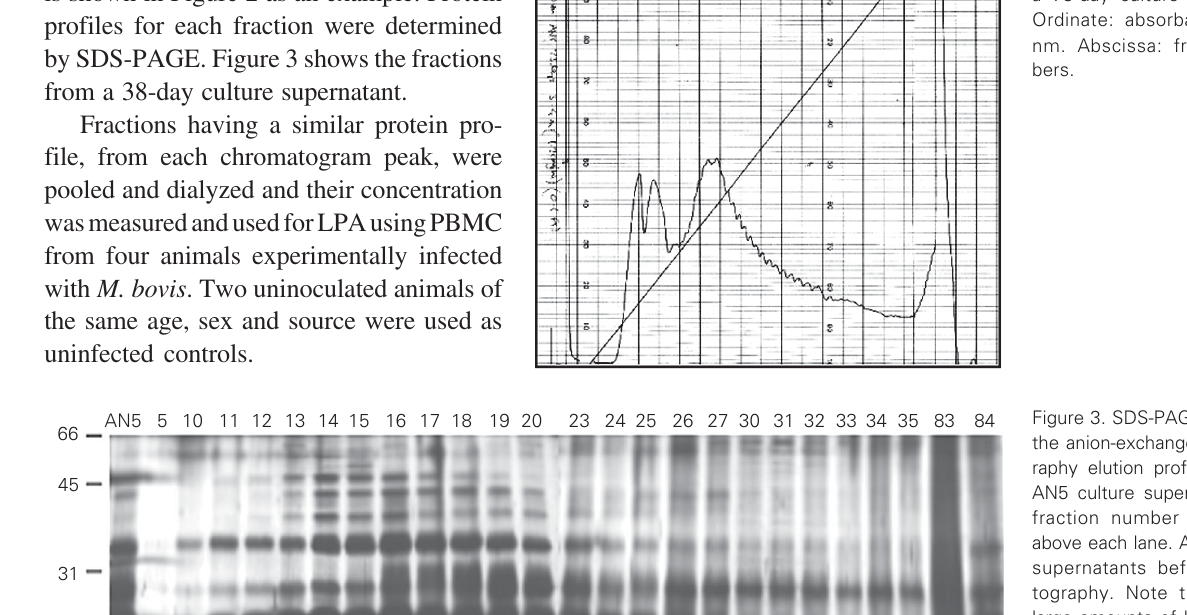
Figure 2. A representative an- ion-exchange chromatogram of a 73-day culture supernatant. Ordinate: absorbance at 280 nm. Abscissa: fraction num- bers.